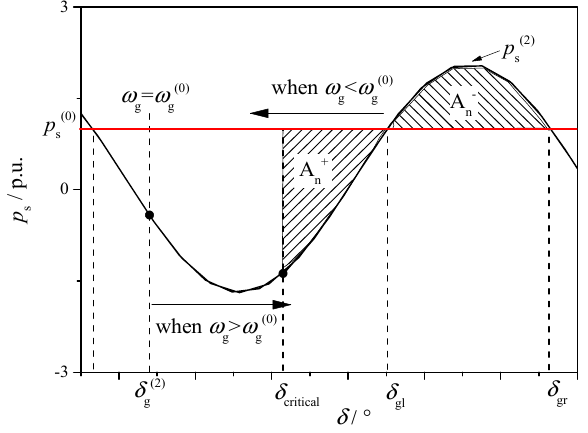
Figure 10. Schematic diagram of the critical phase angle.